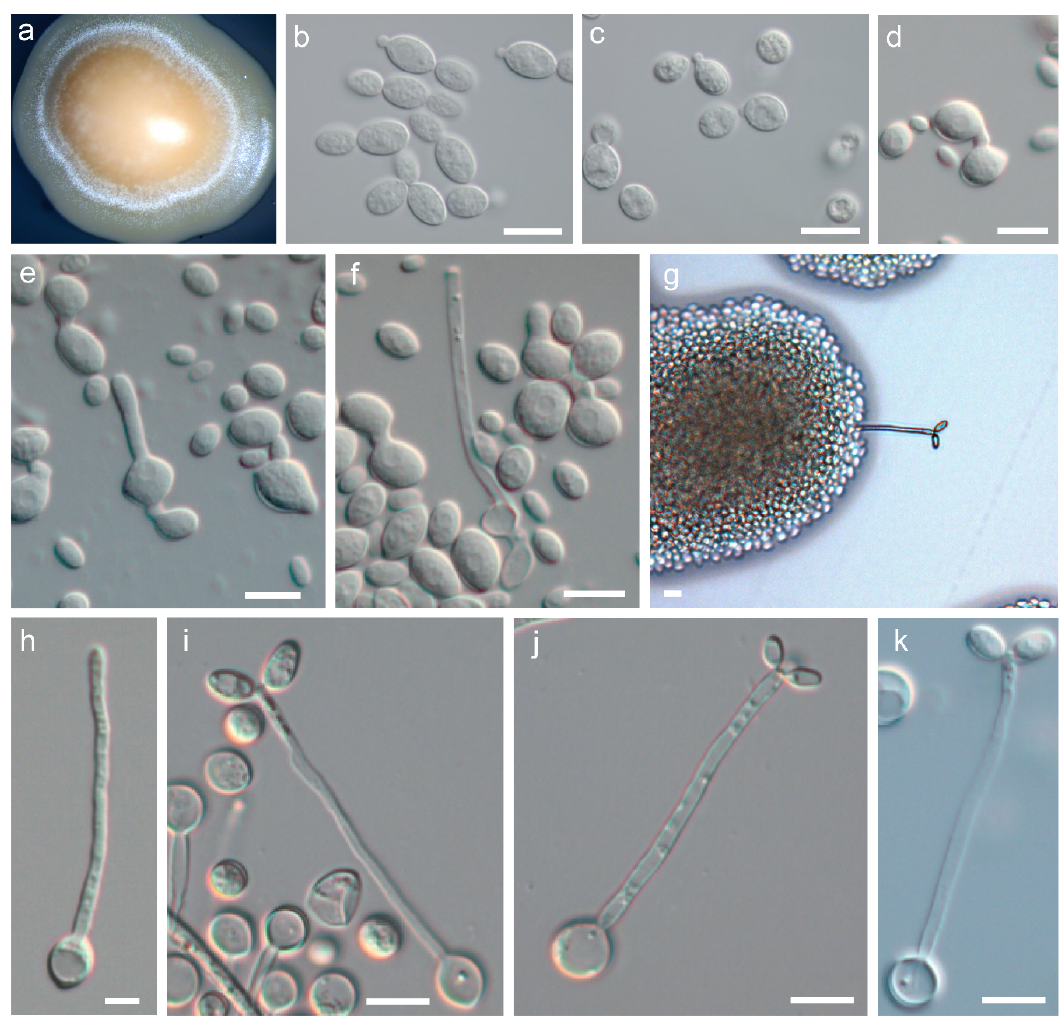
Figure 3. Salient micromorphological features of Phaffia australis sp. nov. and Phaffia tasmanica sp. nov. Orange-salmon colored colony of P. tasmanica PYCC 6947 with a whitish velvet-like margin of aerial basidia and basidiospores ( a ). Yeast cells of P. australis PYCC 6859 T ( b ) and P. tasmanica PYCC 6858 T ( c ) on YPD after 3 days at 20 °C. Cell-cell conjugation ( d ) and subsequent basidium formation ( e – g ) of P. australis PYCC 6859 T . Early stage of basidium development from a single cell of P. tasmanica PYCC 6948 ( h ) and mature basidia with basidiospores ( i – k ) of PYCC 6858 T . All stages of sexual development were studied on ribitol agar incubated at 18 °C and observations were conducted after 3–10 days. Scale bars correspond to 10 µm.